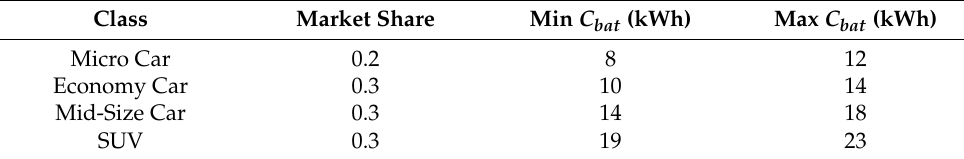
Table 2. HEV classes